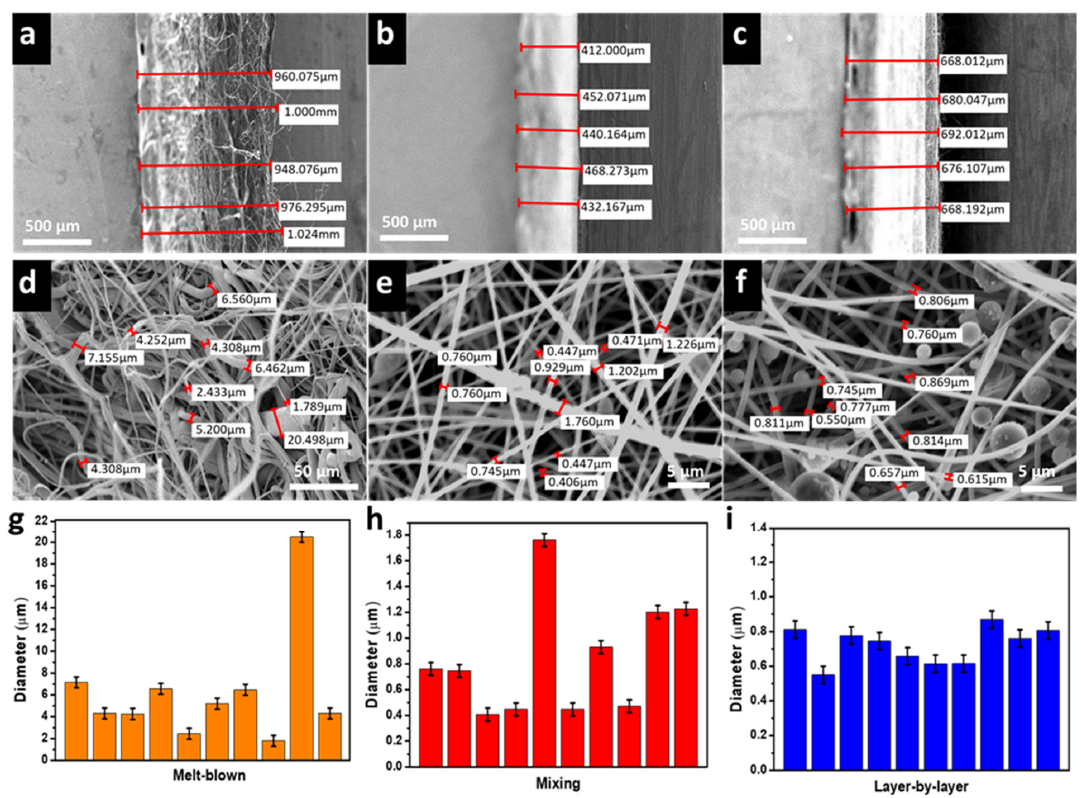
Figure 6. The SEM picture describes the thickness of the melt-blown fabric ( a ), mixing fabric ( b ), and layer-by-layer fabric ( c ). As shown in ( d , e , f ) each fabric fibers thickness is observed and plotted with their corresponding diameter distribution in ( g ) melt-blown, ( h ) mixing and ( i ) layer-by-layer, respectively.